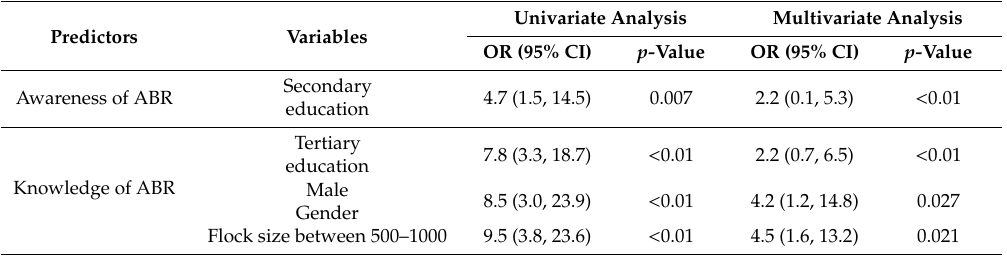
Table 5. Predictors of ABR awareness, satisfactory knowledge, and perceptions of ABR among poultry farmers in Kwara state.